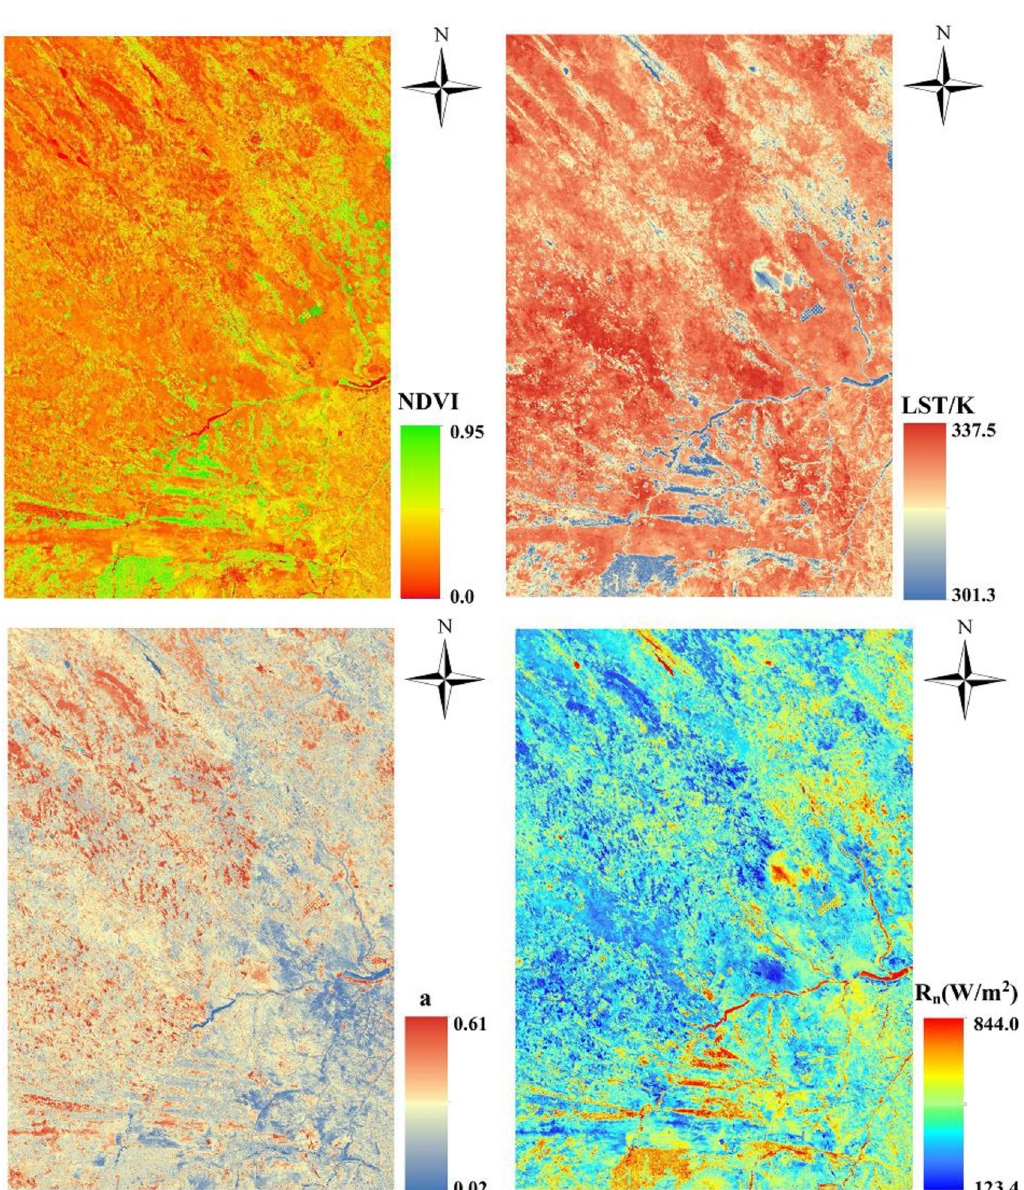
Fig 5. Spatial distribution of the normalized vegetation index, surface temperature, surface albedo and the net radiation flux in the agro-pastoral ecotone of northwest China.